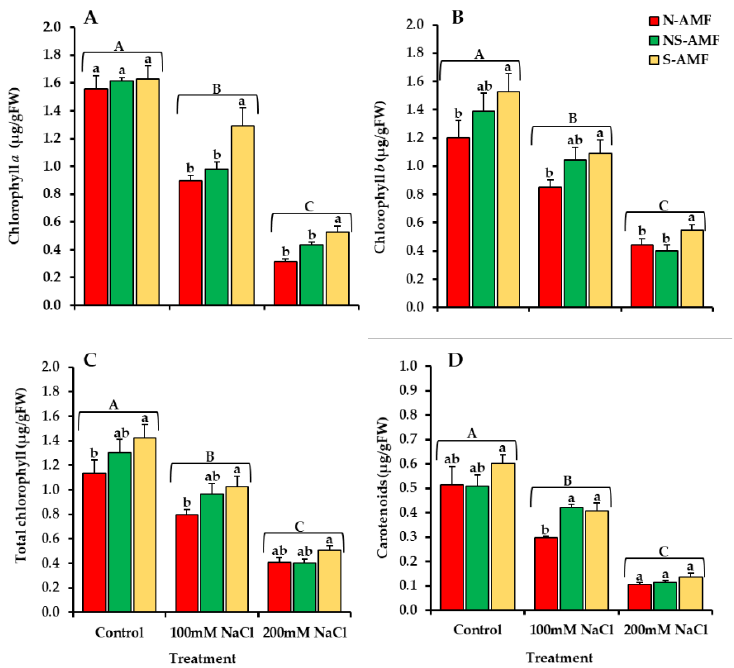
Figure 5. Effect of AM symbiosis (S-AMF and NS-AMF) on chlorophyll a ( µ g/gFW) ( A ), chlorophyll b ( µ g/gFW) ( B ), total Chlorophyll ( µ g/gFW) ( C ), and carotenoid ( µ /gFW) ( D ) synthesis of L. scindicus plants grown under salinity stress (0, 100, 200 mM NaCl). Capital letters indicate the significance of the salinity effect, while small letters indicate the effect of AM symbiosis at p = 0.05 (Tukey’s HSD test).